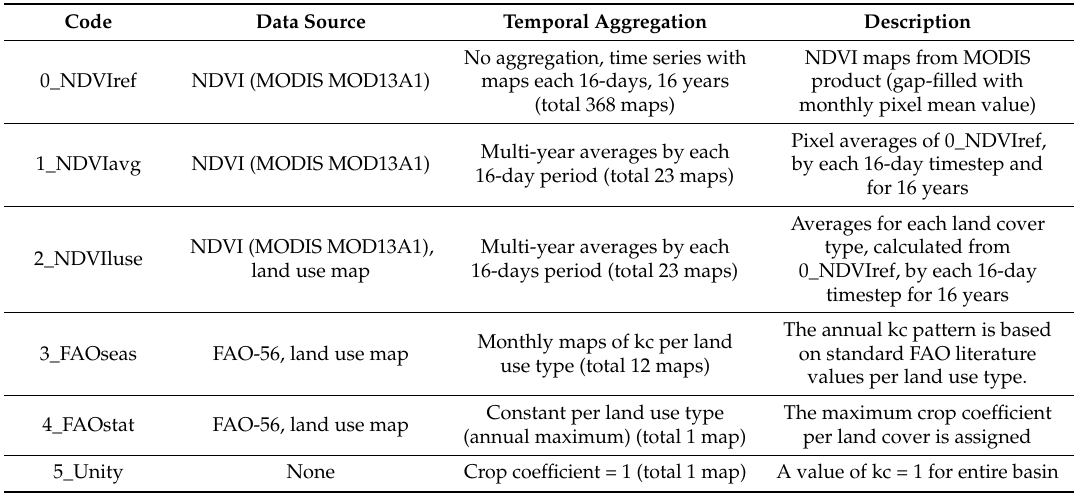
Table 1. Description and inputs for the crop coefficient parameterization methods used.